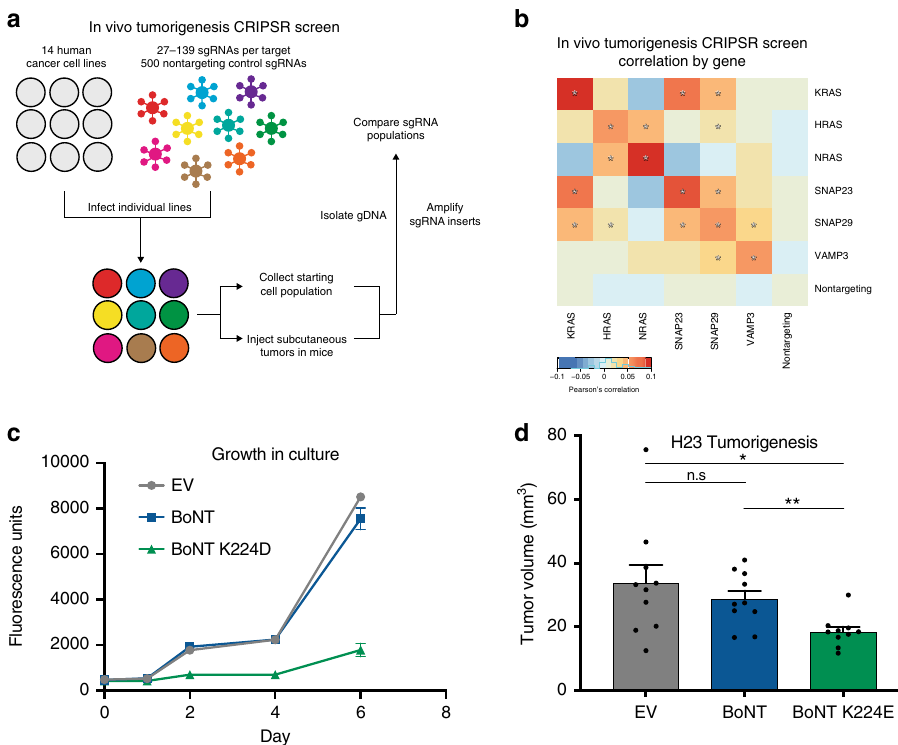
Fig. 7 SNAP23 is a potentially targetable vulnerability of KRAS. a Schematic of a focused co-essentiality CRISPR screen targeting KRAS, HRAS, NRAS, SNAP23, SNAP29, and VAMP3 ( n = 14 tumors). b Correlation of in vivo tumorigenesis sgRNA counts by target gene in CRISPR screen. c Growth in culture of H23 expressing BoNT light chain E (LC/E) and LC/E K224D ( n = 2). d Tumor volumes of H23 expressing BoNT light chain E (LC/E) and LC/E K224D at day 16 ( n = 10 tumors per condition). Error bars are